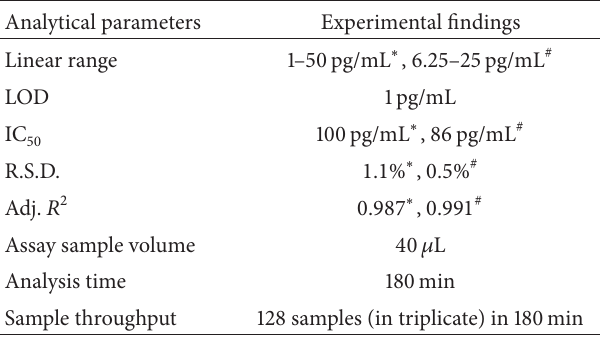
Table 2: Analytical figures of merit of the fluorometric assay developed for analysis of